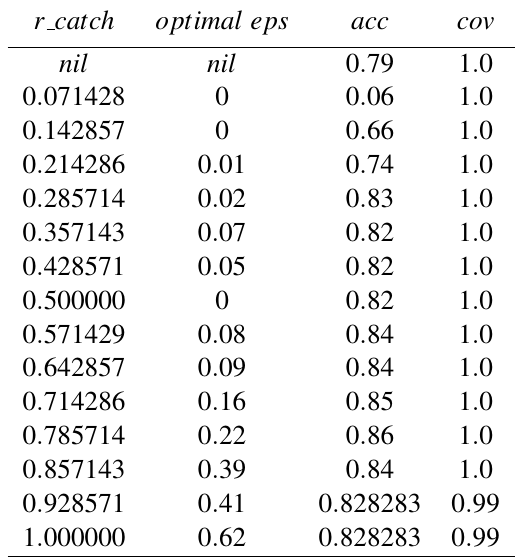
Table 4. Results of voting by granules of training objects; r catch=catch radius, optimal eps=Best ε , acc= accuracy, cov= coverage